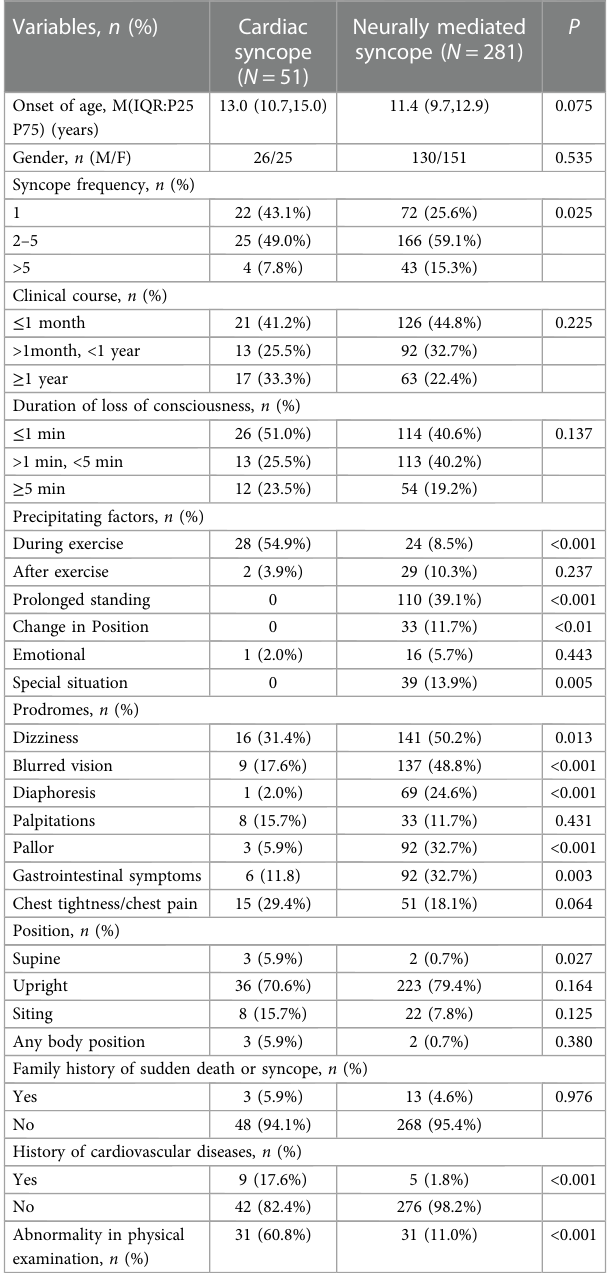
TABLE 2 Demographic and clinical features of children